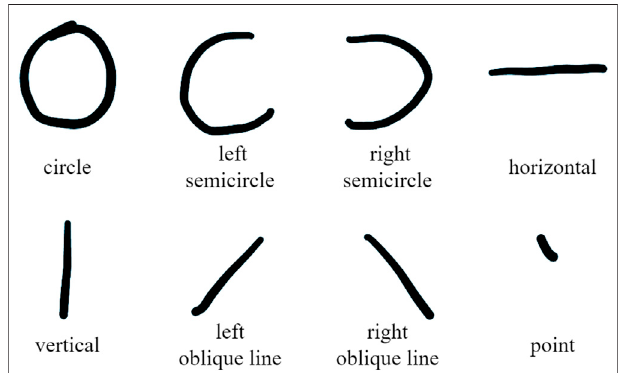
FIGURE 5 | Eight types of strokes that make up a character.